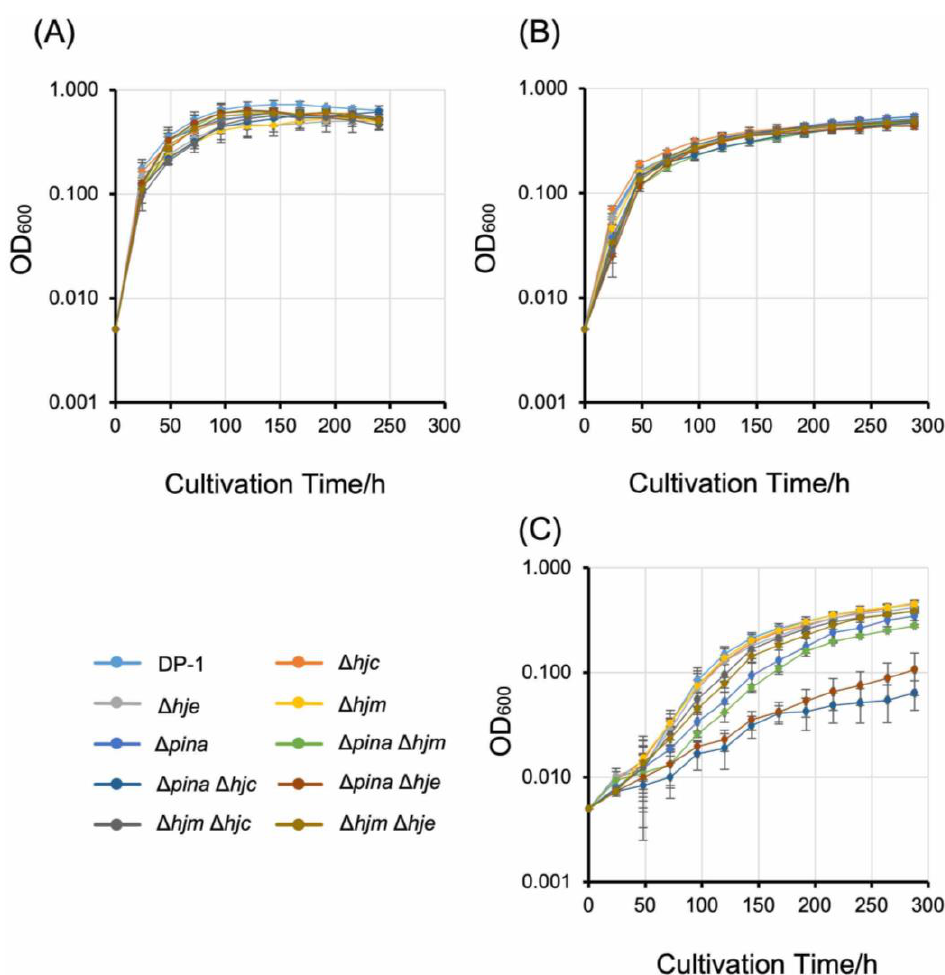
Figure 3. Growth curves of the gene-deleted strains. Overnight cultures of the gene-deleted strains and DP-1 strain were cultivated at 75 °C ( A ), 65 °C ( B ), and 55 °C ( C ). The error bars indicate ±SD calculated using three biological replicates.